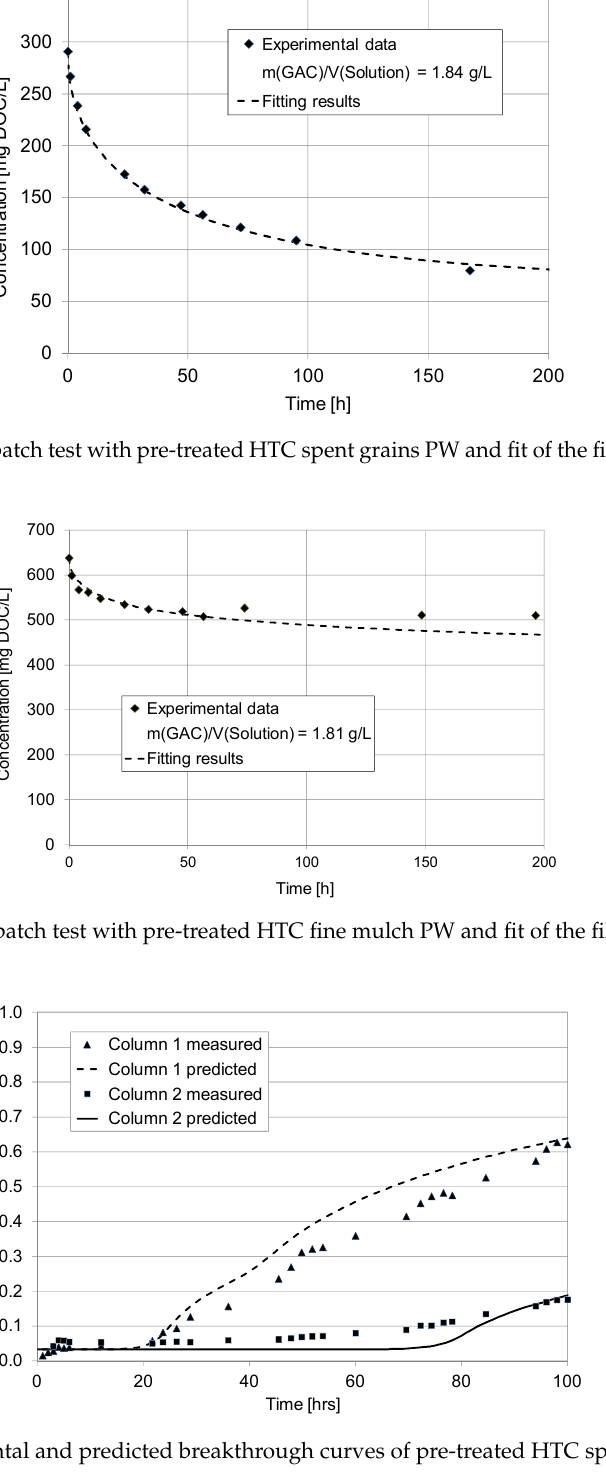
Figure 6. Experimental and predicted breakthrough curves of pre-treated HTC spent grains PW. Figure 7. Experimental and predicted breakthrough curves of pre-treated HTC fine mulch PW.